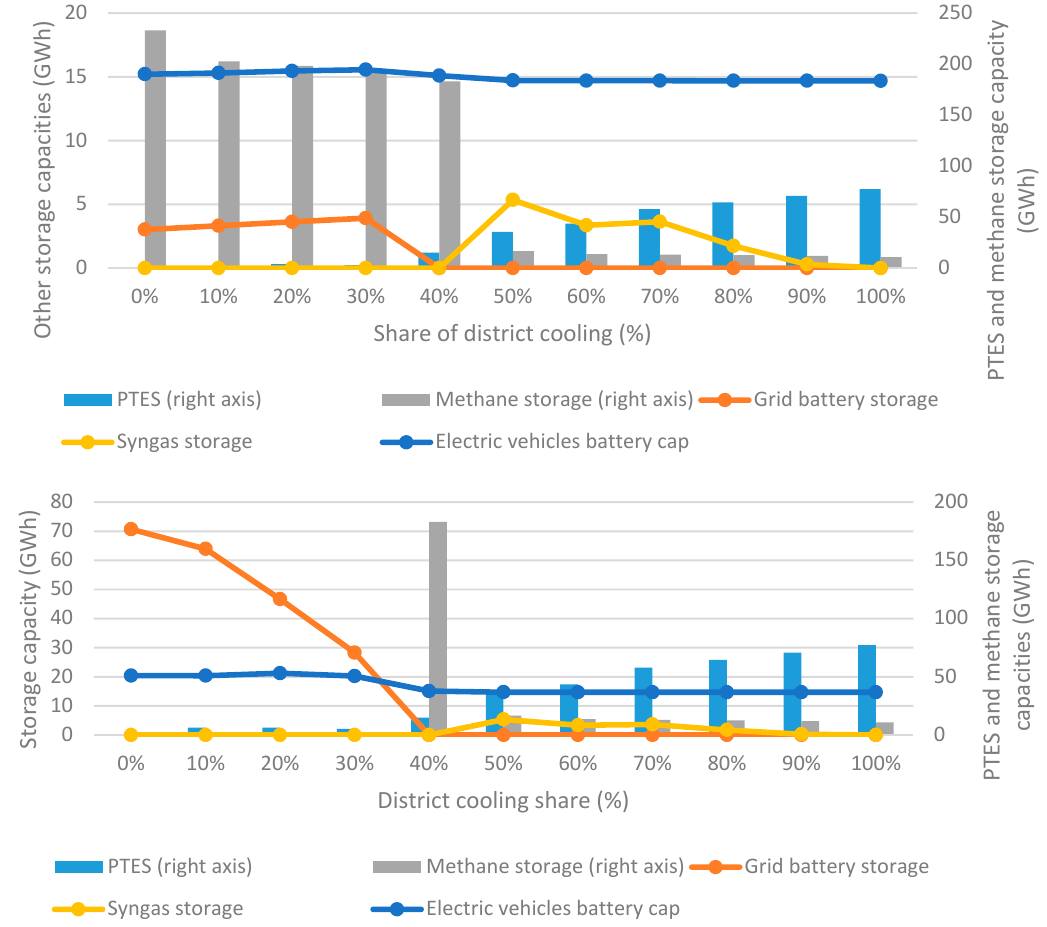
Figure 3. Optimal storage capacities in PV constrained ( Top ) and unconstrained PV ( Bottom ) scenarios. Note the difference in orders of magnitude between right and left y-axes.